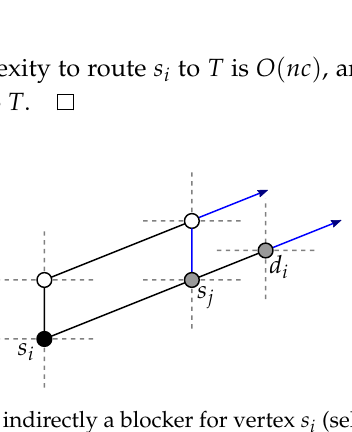
Figure 3. Vertex d i can be indirectly a blocker for vertex s i (selected paths in blue) [9].